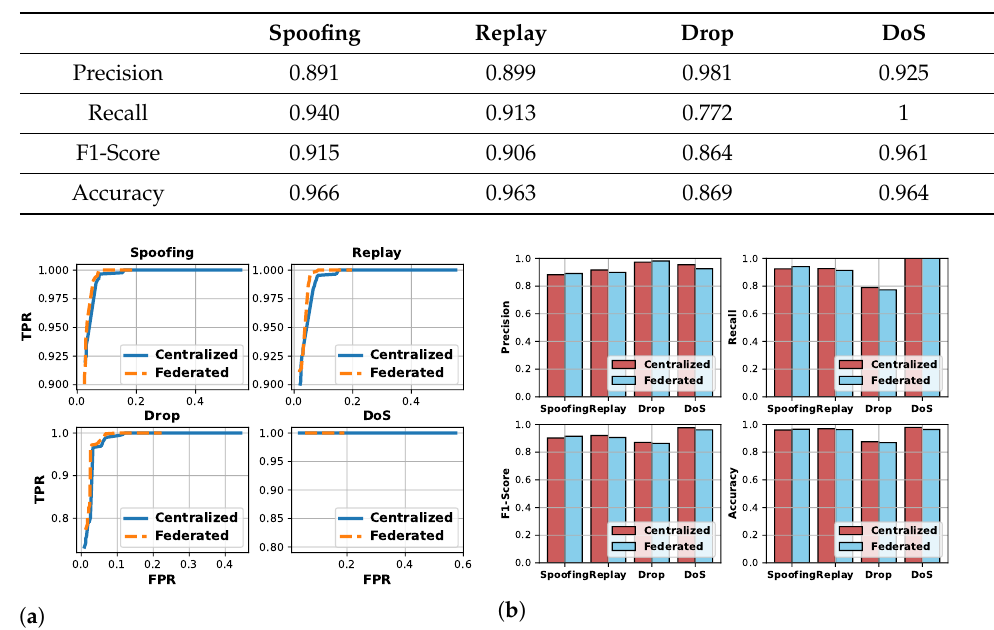
Figure 8. Results: #clients, energy consumption (J), and latency (s). Table 5. Numerical results: Federated ConvLSTM.